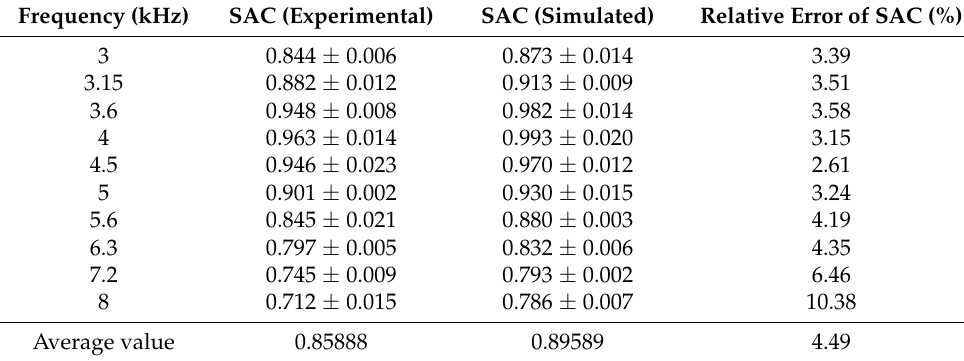
Table 2. The relative error data of SAC